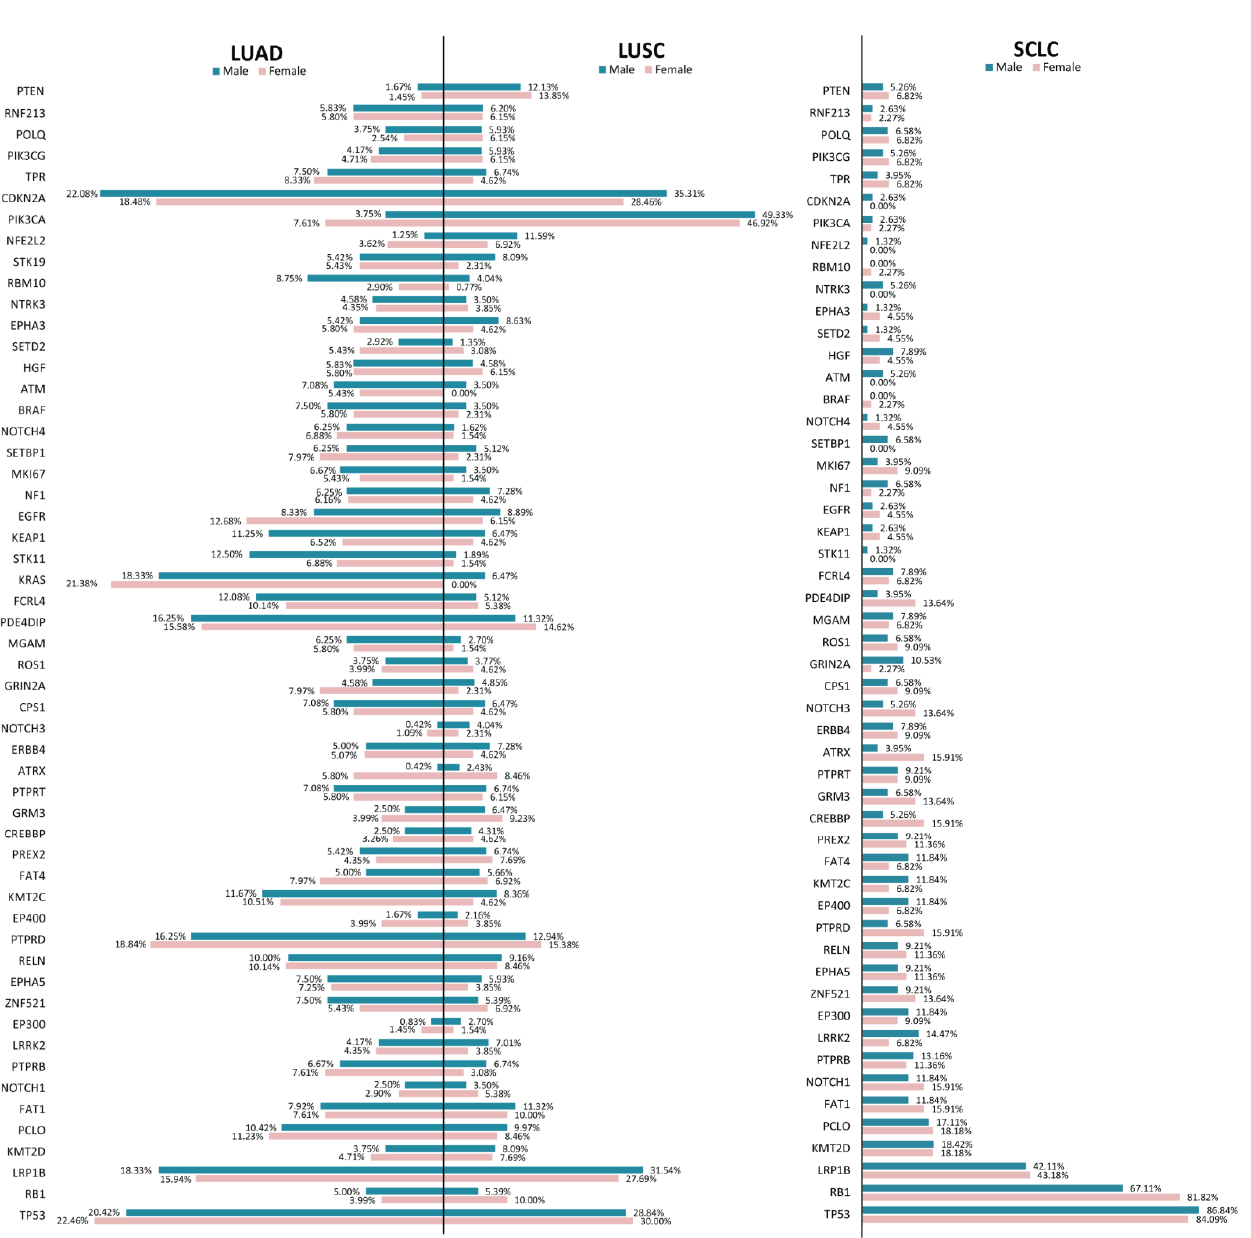
Figure 3. Bar graphs represent the frequencies of altered genes in women (pink) and men (blue) for each dataset (LUAD, LUSC, and